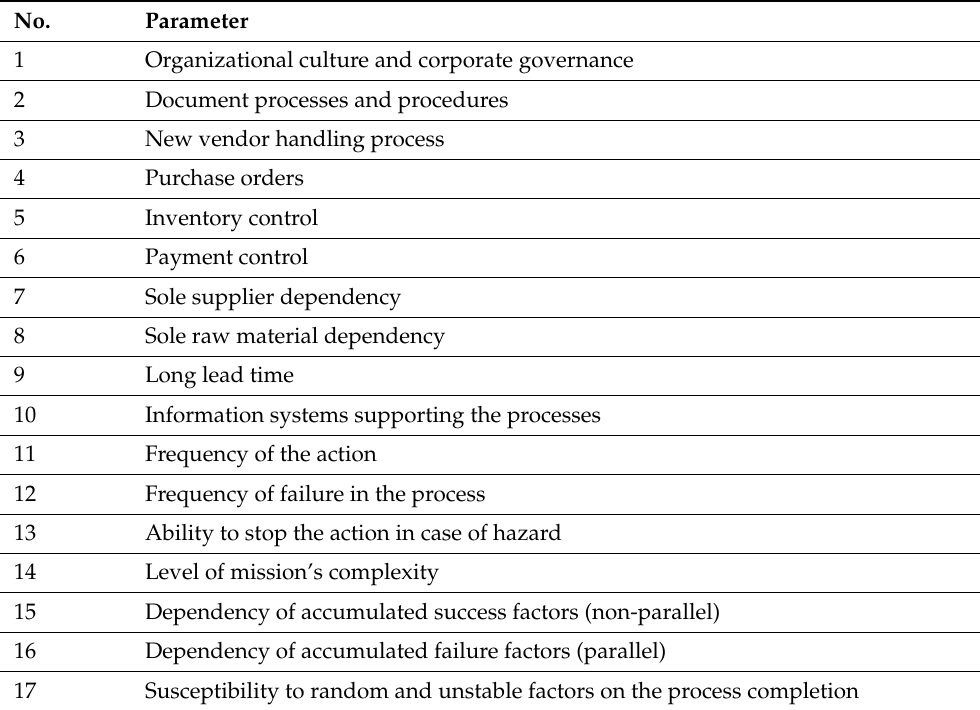
Table 1. List of parameters in the input